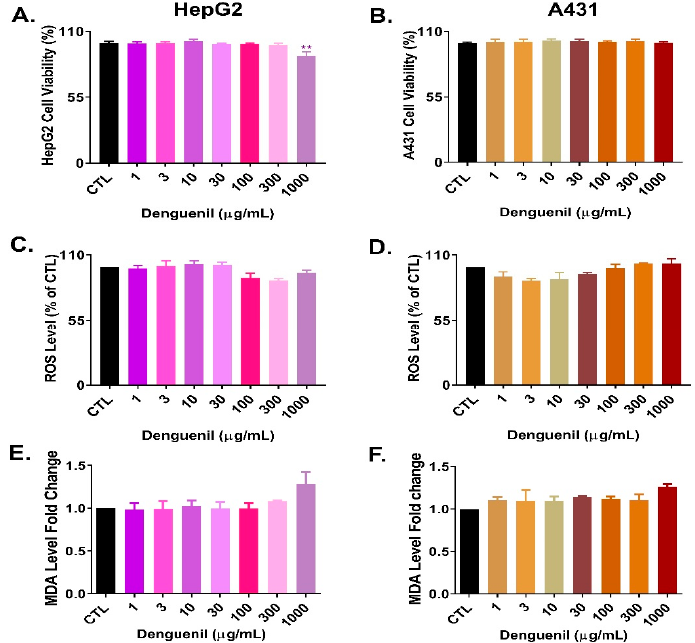
Figure 7. Cytosafety of Denguenil in human cell lines. HepG2 and A431 cells were treated with a series of Denguenil concentrations for 24 h and tested for various endpoints. In ( A ) HepG2 cells and in ( B ) A431 cells, Denguenil exerted no cytotoxicity up to the highest tested concentration of 1000 µ g / mL. Reactive oxygen species (ROS) generation was measured ( C ) In HepG2 and ( D ) A431 cells. MDA secretion in cell culture supernatant was estimated in ( E ) HepG2 and ( F ) A431 cells. n = 3, data are presented as means ± SEM. **, p < 0.001, represents statistically significant as compared to untreated control